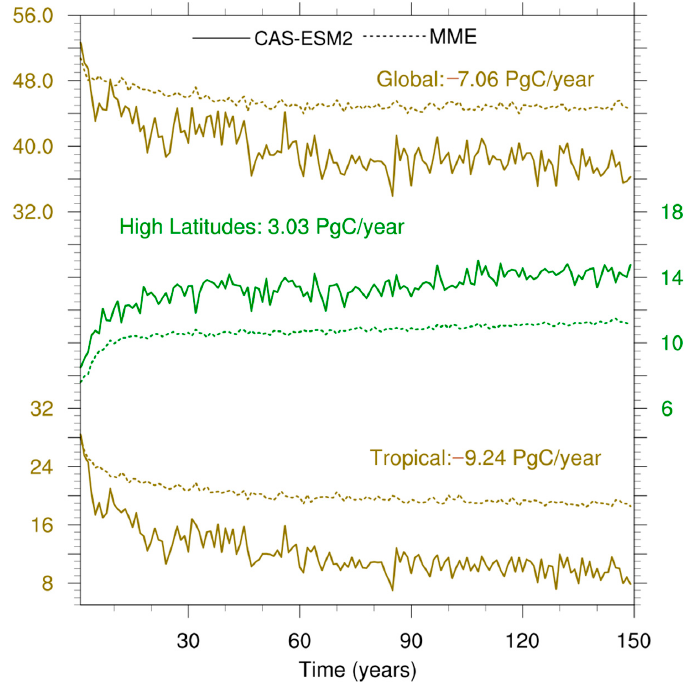
Figure 5. Time evolution of NPP anomalies (units: PgC year − 1 ) for the CAS-ESM2 (solid lines) and multi-model ensemble (MME, dashed lines) over the globe (top lines), northern high latitudes (middle lines), and tropics (bottom lines). The numbers represent differences in NPP anomalies between the CAS-ESM2 and MME for the last 30 years.